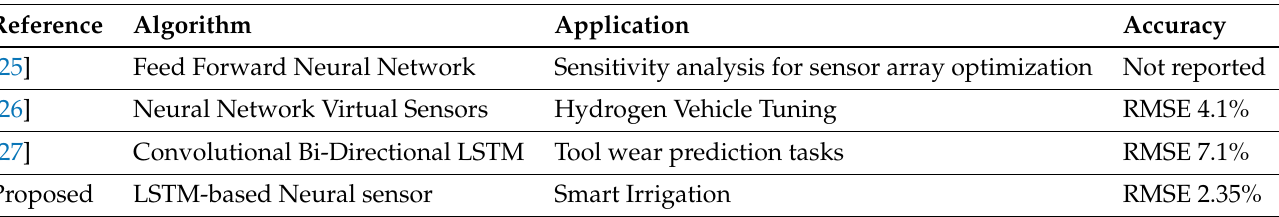
Table 5. Comparison with other state-of-the-art